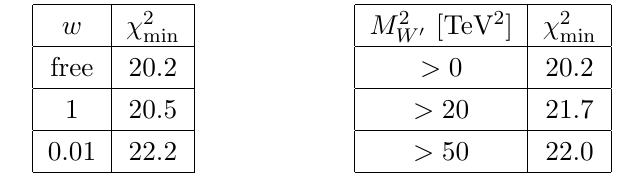
Table 3 . Impact on the (cid:31) 2 from (left) w , and (right) M W 0